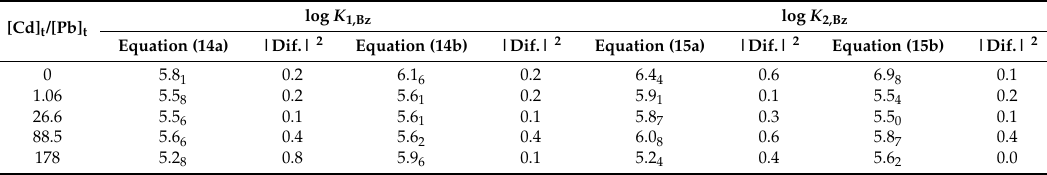
Table 3. Comparison between Equations (14a) and (15a) and Equations (14b) and (15b) in the re-production of the experimental K 1,Bz and K 2,Bz values 1 at 298 K. [Cd] t /[Pb]